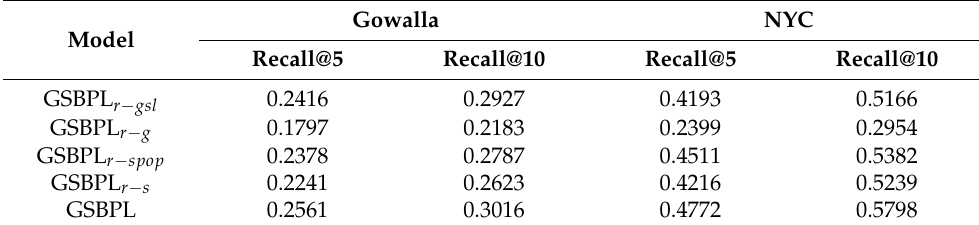
Table 3. Ablation study of different derivative models of